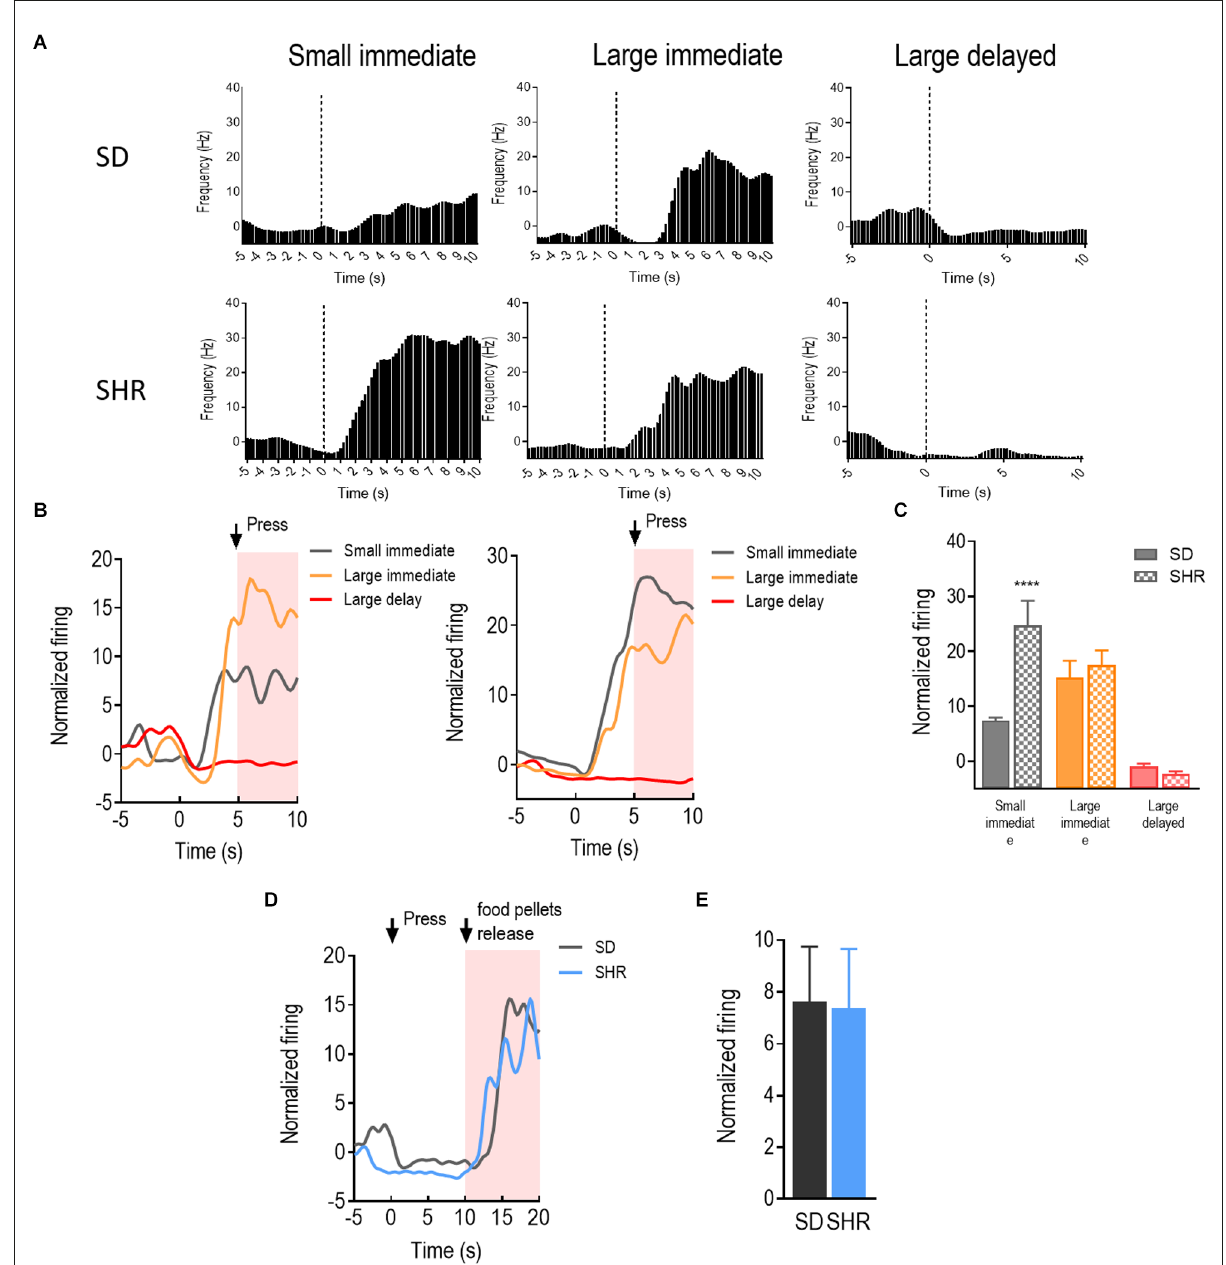
FIGURE3 The medial prefrontal cortex (mPFC) neurons respond to reward in SD and SHR rats. (A) Peri-event histograms of representative mPFC neurons in SD rats (upper panel) and SHR rats (lower panel) in response to the sized reinforcer. Data are aligned to reward onset (lever pressing at time 0, dashed line). (B) Normalized firing rate of all mPFC neurons in response to sized reinforcer in SD rats (left panel) and SHR (right panel) rats. (C) Quantification of the normalized firing rate of mPFC neurons in both SD and SHR rats during the 5 s period in response to the lever press (highlighted box). (D) Normalized firing rate of all mPFC neurons’ response to large delayed reinforcer in SD and SHR rats. (E) Quantification of the normalized firing rate of mPFC neurons in both SD and SHR rats during the 5 s period after the release of the large delayed reinforcer. **** p < 0.05 compared with SD